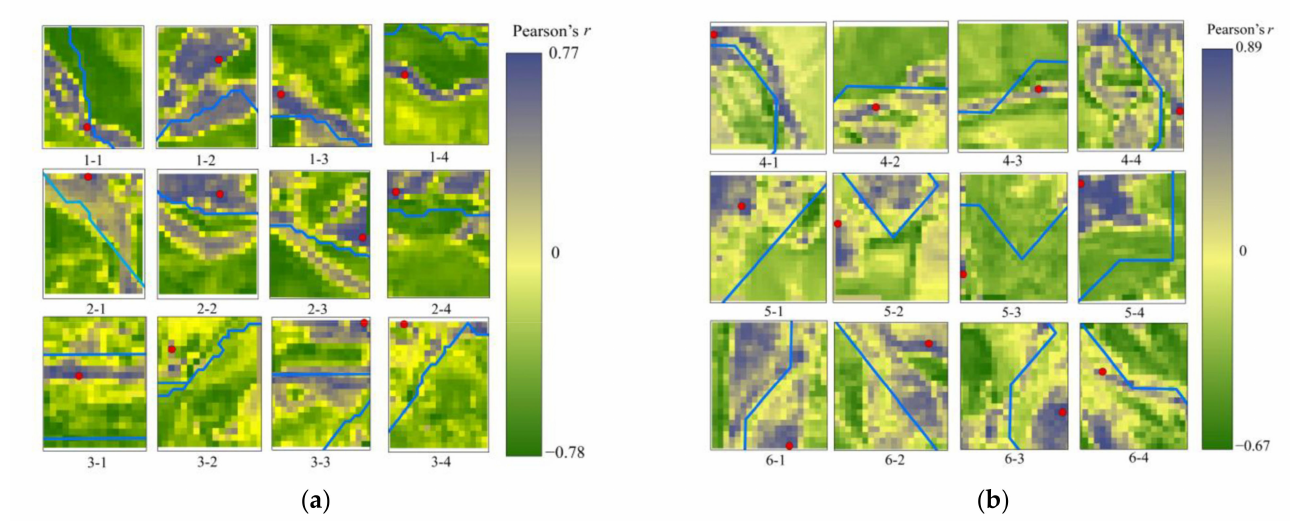
Figure 4. Pearson’s r correlation coefficient images of the C/M value of each pixel and observed discharge in time series. Red dots represent the finally selected location of the M pixel. ( a ) The Heihe River Basin; ( b ) The Murray Darling